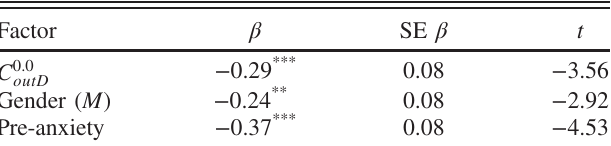
TABLE IV. Summary of the simplified linear regression model for anxiety shift with outdegree centrality from fourth collection ( α ¼ 0 . 0 ) and with the final grade factor removed: The stand- ardized estimate ( β ), the standard error for the standardized estimate (SE β ), and t -test statistic ( t ). We consider networks without instructional staff. Significant p values are marked with an